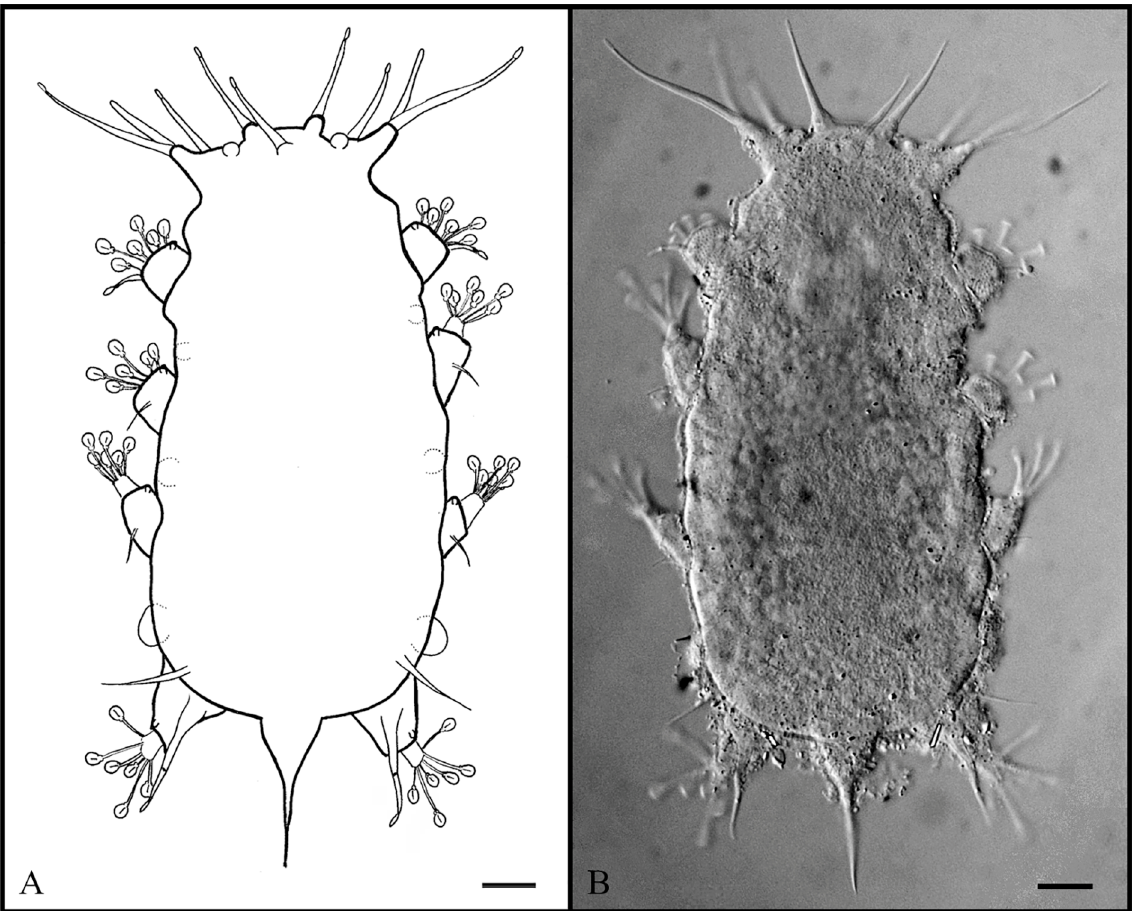
Fig. 2. Batillipes algharbensis sp. nov. A . Schematic drawing, dorsal view. B . habitus of the holotype, ♀, dorsal view. Scale bars = 10